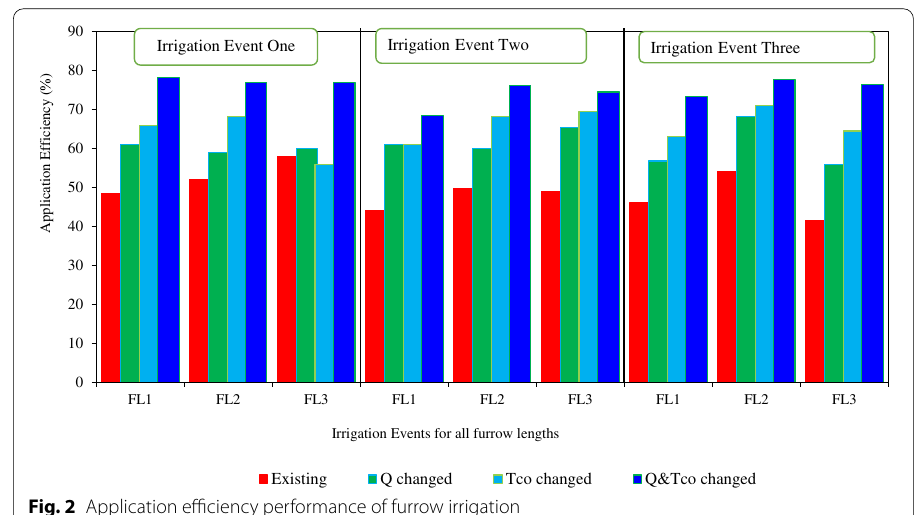
Fig. 2 Application efficiency performance of furrow